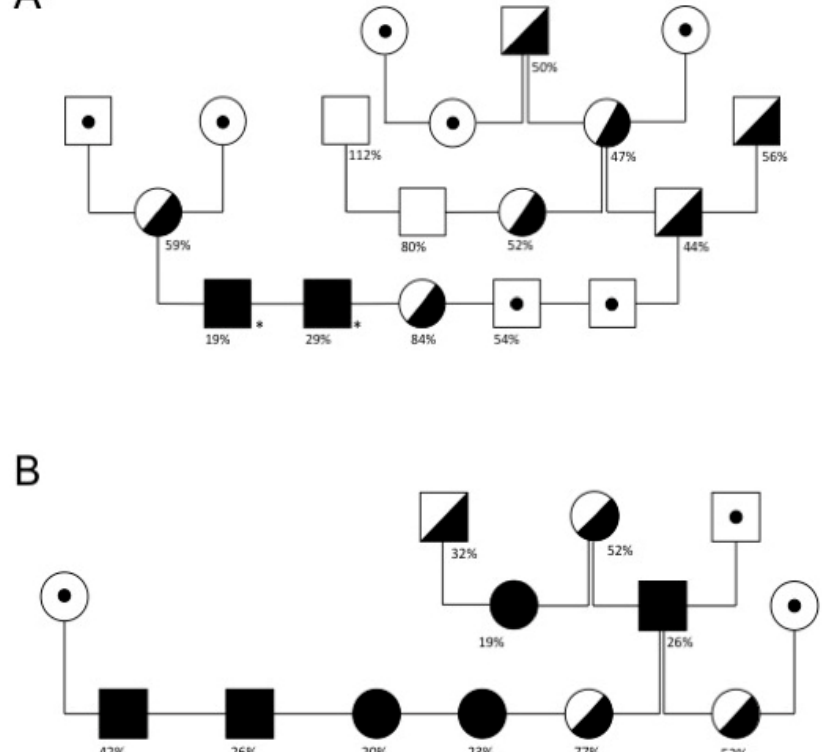
Figure 2. Maine Coon cat core family pedigrees. Pedigrees of the MCC core family from ( A ) the cattery of the index case and ( B ) a related cattery. FXI activity and excessive bleeding phenotype are indicated. Squares and circles represent males and females, respectively. Filled symbols indicate cats homozygous for the FXI-V516M with low FXI activity and/or prolonged aPTT. Half-filled symbols indicate cats that are carriers of the FXI-V516M variant. Percentage numbers below symbols indicate FXI activities. The black asterisk indicates animals with known clinical signs of bleeding. Symbols with a dot represent untested cats. Not all animals of the core family are shown in this pedigree.